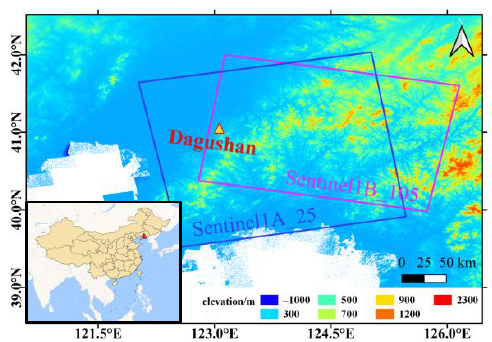
Figure 2. Location of Dagushan Iron Mine, with the TanDEM-X 90 m DEM as background.